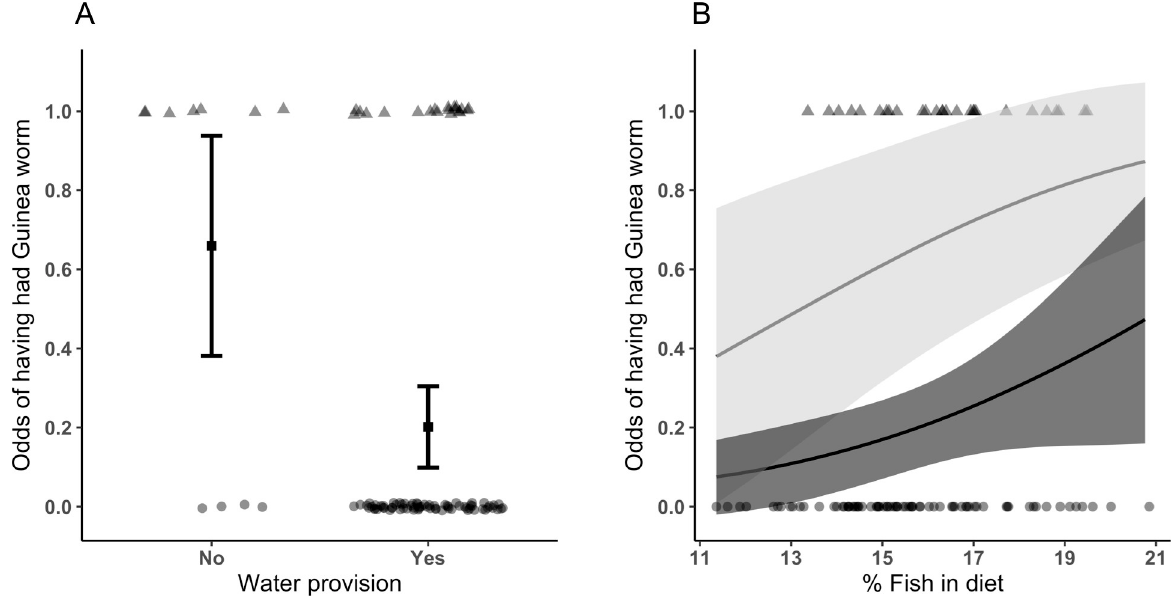
Fig 4. Effects of water provision and of fish consumption on Guinea worm infection history in dogs in Chad. The odds, with 95% confidence intervals, of having had Guinea worm are shown for dogs A) living in households in which animals are, and are not, provided with water, and B) with different modelled proportions of fish in their diets. The effects of fish consumption are presented separately for dogs living in households, in which animals are (dark grey) and are not (light grey) provided with water. Odds are from exponentiated model coefficients describing the relationship between the history of Guinea worm infection from our field survey, averaged across the top model set and for the different levels of values of predictive factors. Results presented are from dogs in Kakale but dogs in Magrao show the same relationships.